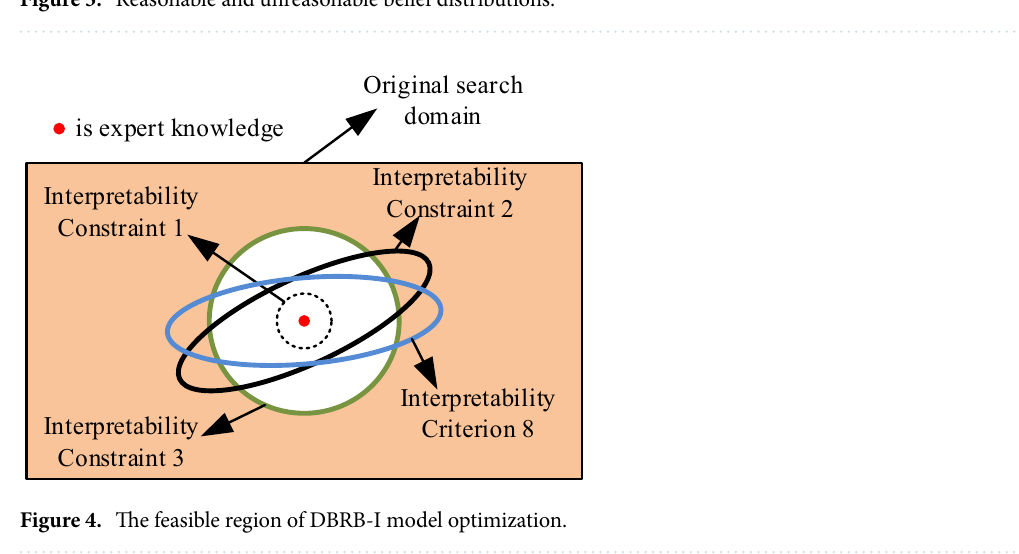
Figure 3. Reasonable and unreasonable belief distributions.